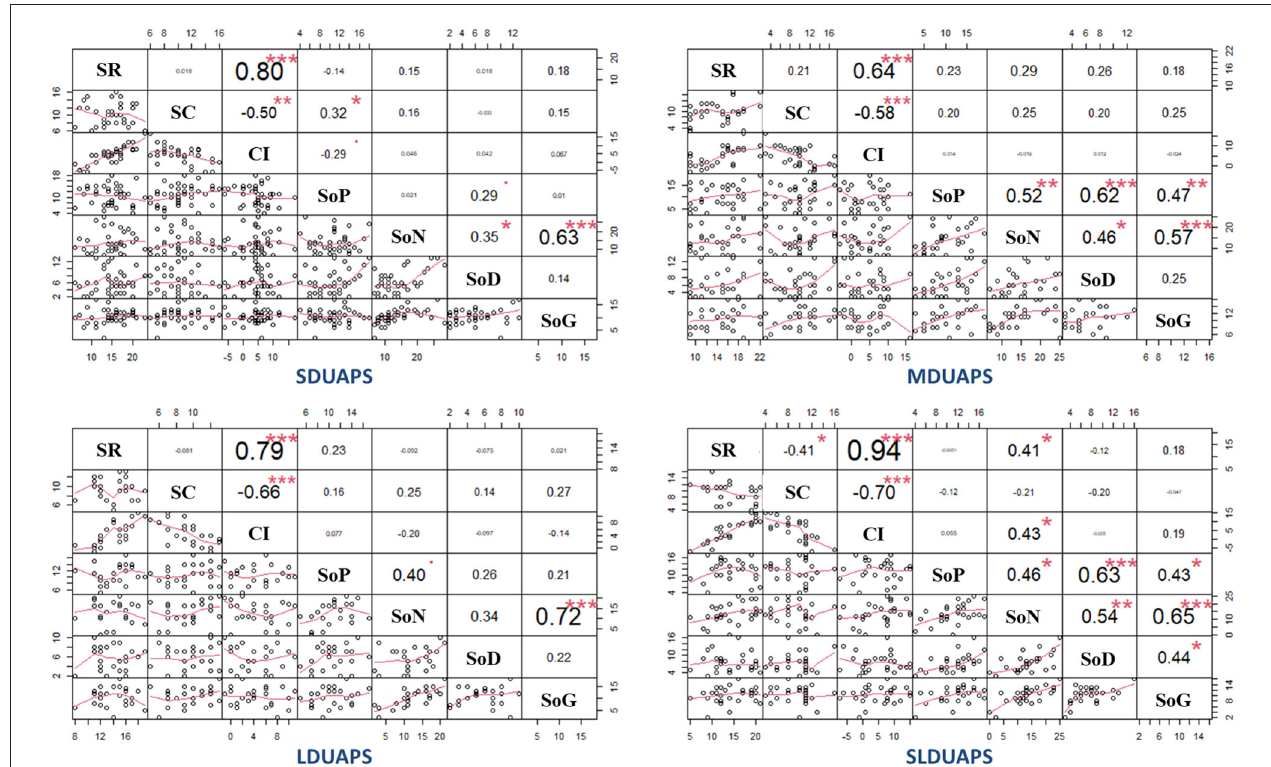
FIGURE 1 | Correlation (Spearman) between cognitive insight and clinical symptoms. DUAPS is the duration from the onset of prodromal symptoms to the first visit to seek professional help; SDUAPS, MDUAPS, LDUAPS, and SLDUAPS refer to 0–3, 4–6, 7–12, and > 12 months, respectively; SR refers to self-reflectiveness; SC refers to self-certainty; CI refers to composite index; SoP refers to the total score of positive symptoms of the Scale of Psychotic-risk Syndromes (SOPS); SoN refers to the total score of negative symptoms of SOPS; SoD refers to the total score of disorganized symptoms; SoG refers to the total score of general symptoms. * p < 0.05; ** p < 0.01; *** p <